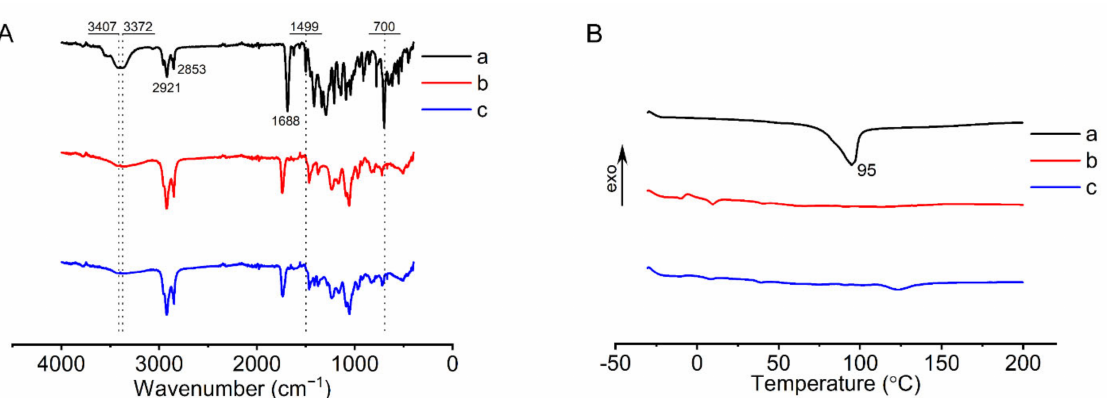
Figure 5. Characterization of MVL(F+E+I): ( A ) FTIR spectra of FOP ( a ), liposomal membranes without FOP ( b ), and liposomal membranes with FOP ( c ). ( B ) DSC profiles of FOP ( a ), liposomal membranes without FOP ( b ), and liposomal membranes with FOP ( c